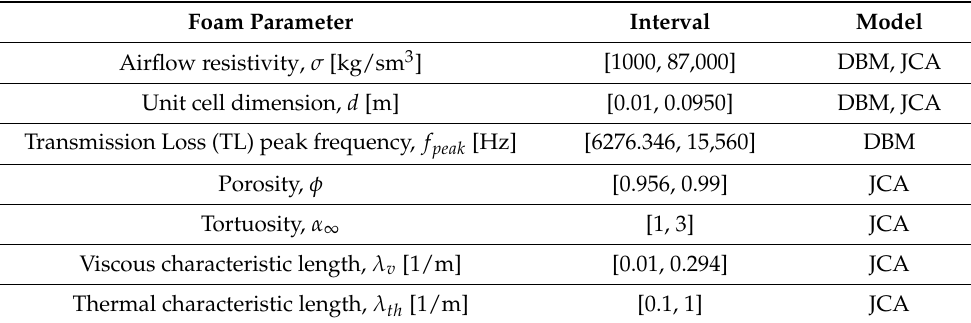
Table 1. Intervals of foam